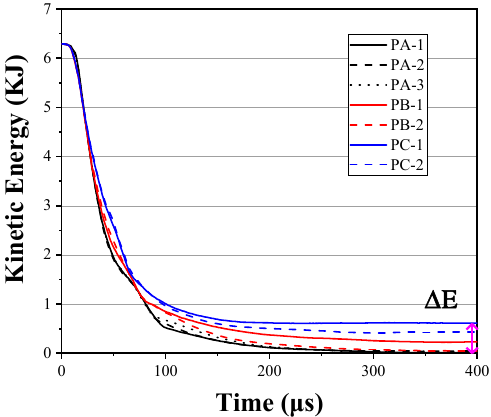
Figure 19. Time history of projectile kinetic energy at varying impact positions.